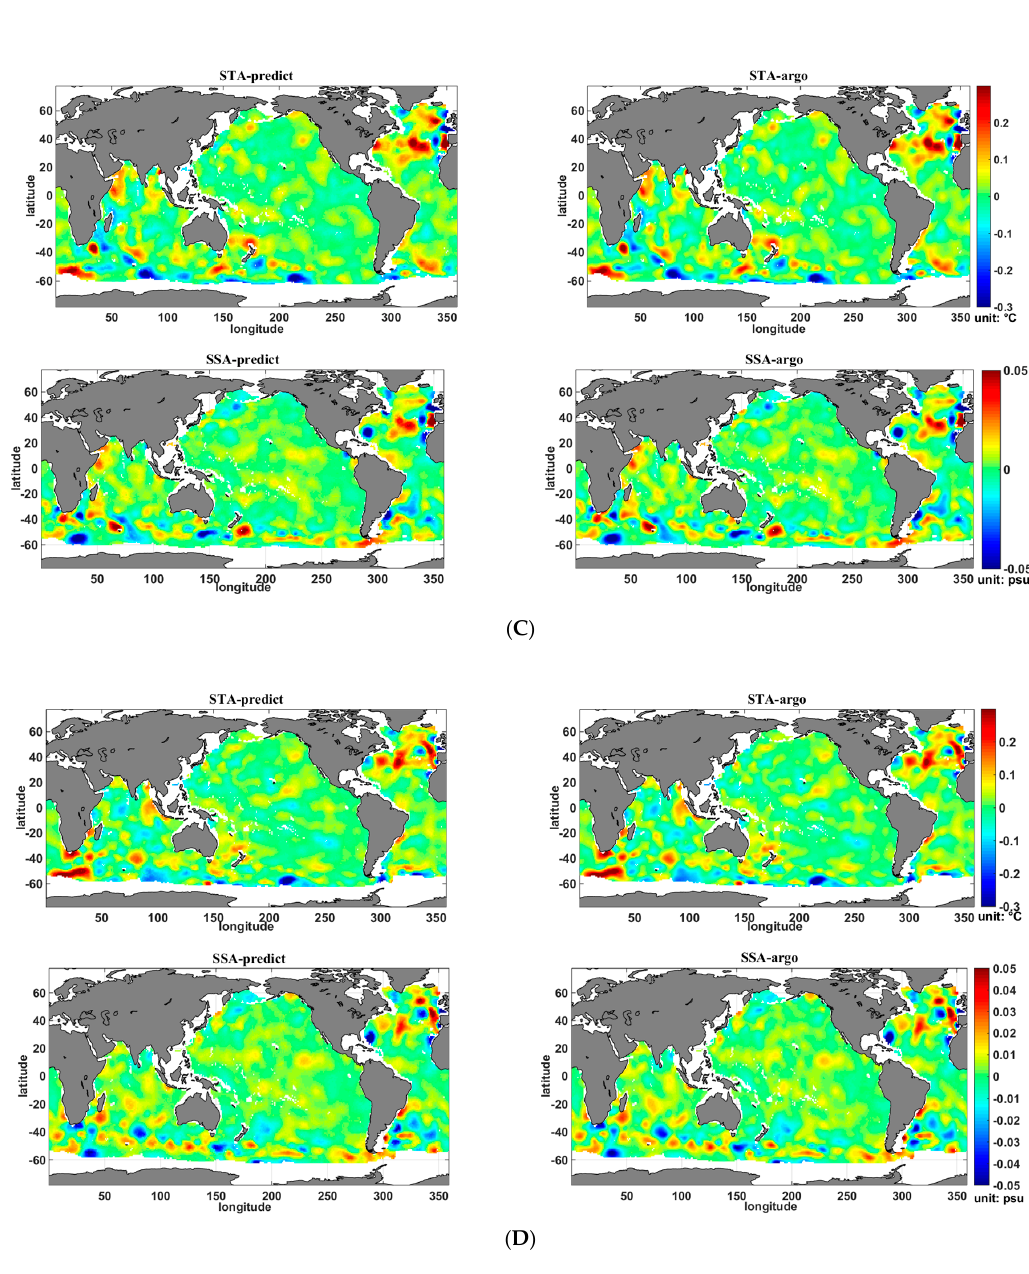
Figure 5. Spatial distribution of STA and SSA from the XGBoost-estimated results and the Argo data at 1500 m for the different seasons in 2015: ( A ) January, ( B ) April, ( C ) July, and ( D ) October.